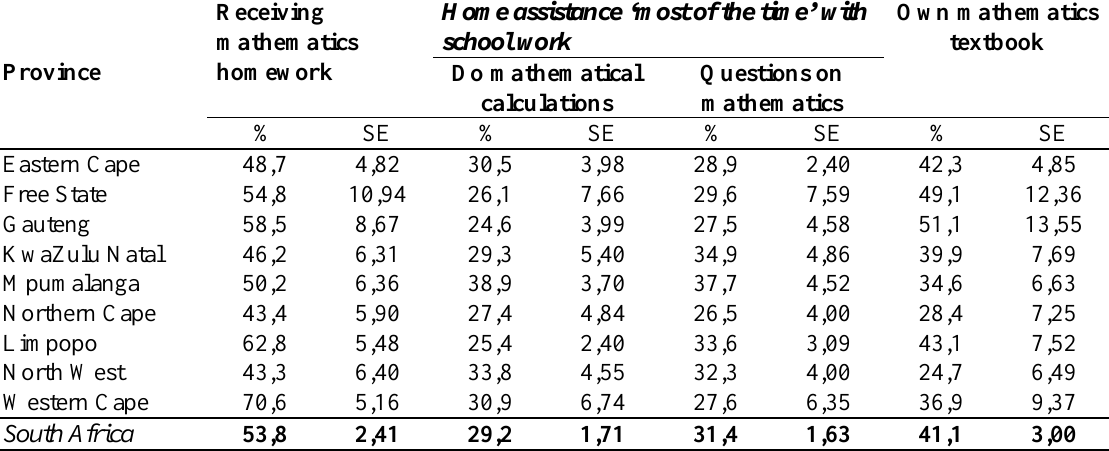
Table 5. Learners’ involvement with mathematics